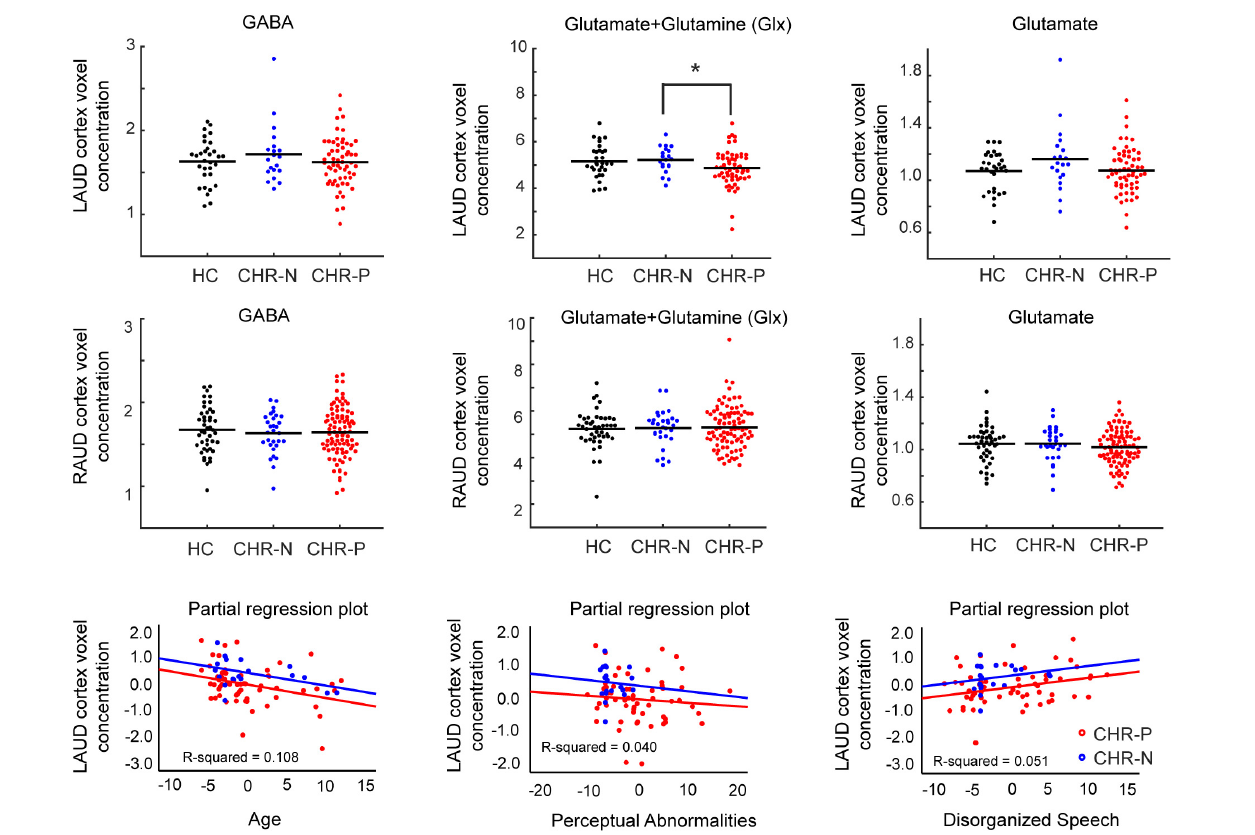
FIGURE 2 | Metabolite concentrations and correlations. Distributions of main metabolite concentrations (GABA, Glx, and Glutamate), referenced to water, shown for left (LAUD: top row) and right (RAUD: second row) cortex voxel, and for all main groups (HC, CHR-N, and CHR-P). Significant group differences are indicated with an asterisk. Group means are indicated by a horizontal line. The bottom row shows scatter plots of partial regression correlations between LAUD z scored Glx levels and age of the participants (left), CAARMS Perceptual Abnormality scores (middle), and CAARMS Disorganized Speech scores (right). Groups are color coded, with black used for the HC group, blue for the CHR-N group and red for the CHR-P group. HC, healthy controls; CHR-N, Clinical-High-Risk negative: CHR-P, Clinical-High-Risk positive group; LAUD, left auditory MRS voxel; RAUD, right auditory MRS